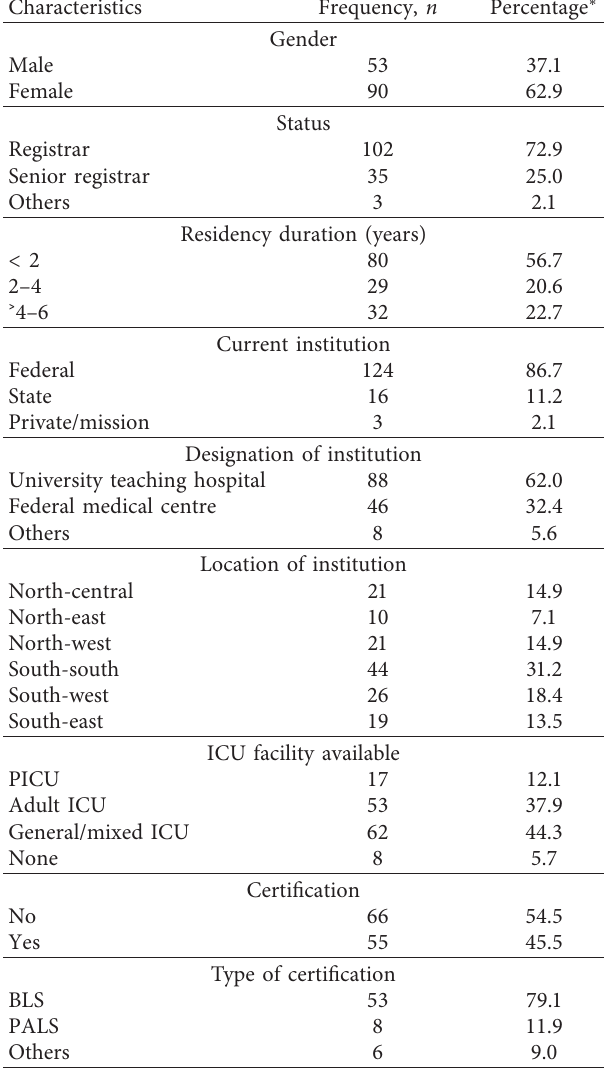
Table 2: Types and outcomes of critical illnesses managed by the participants in the preceding 3 weeks ( N �